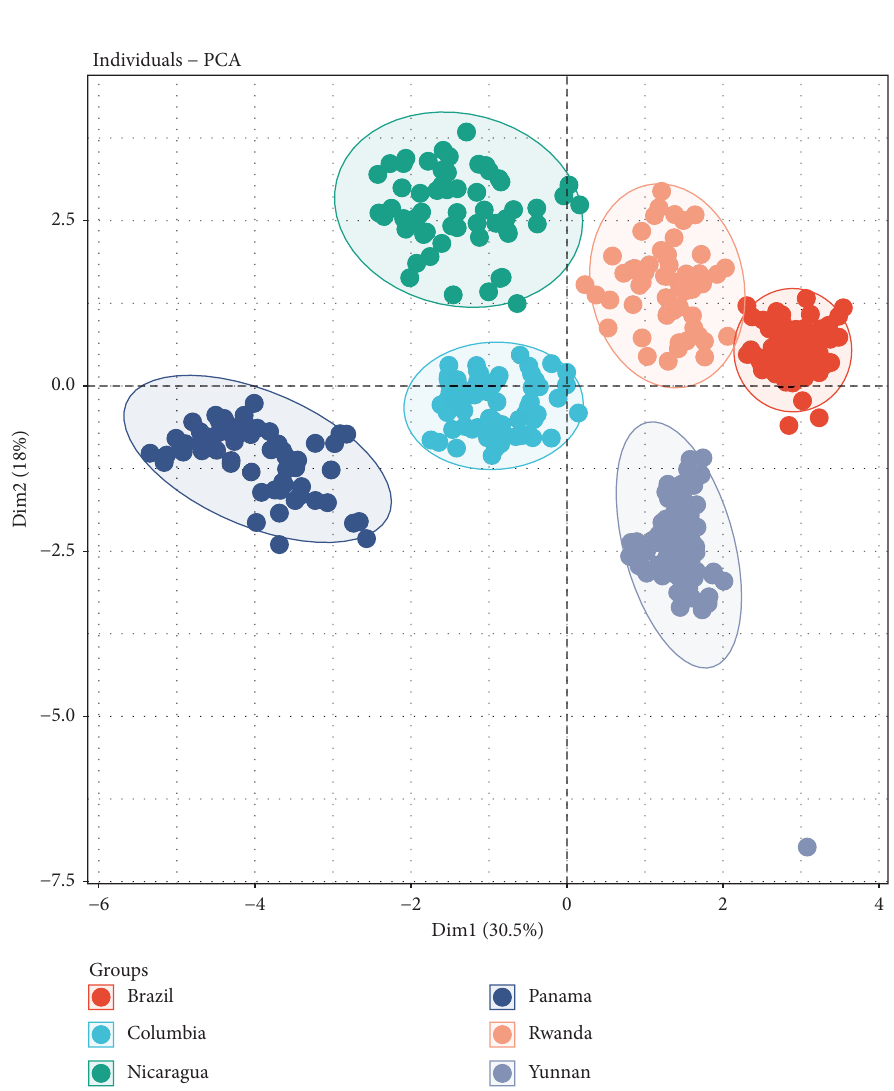
Figure 2: RF identifcation model of mixed cofee bean samples from six diferent original